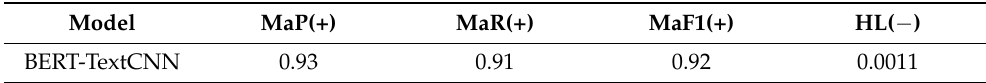
Figure 5. Perceived Risk Labels Match Process and Results. Table 3. Performance of Multi-Label Classification